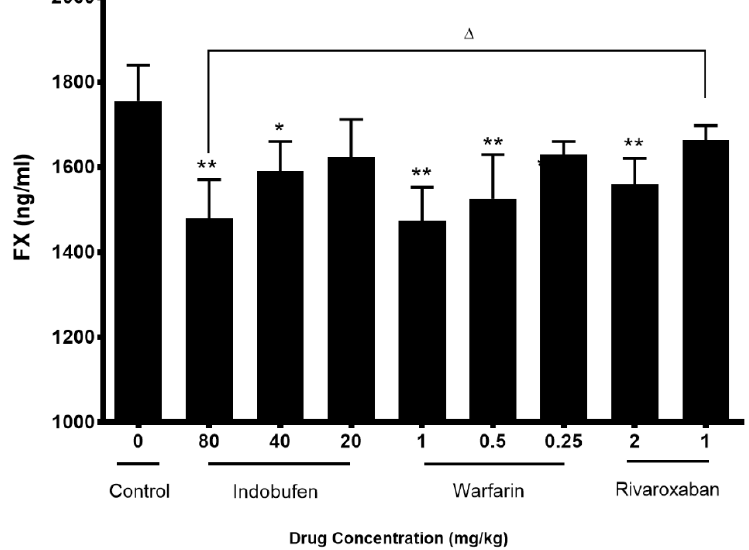
Figure 7. The effects of indobufen on the content of coagulation factor 10 (FX) in rats. * p < 0.05, ** p < 0.01 versus the control group; △ p < 0.05 versus the rivaroxaban 1 mg/kg group (mean ± S.D., n = 10).